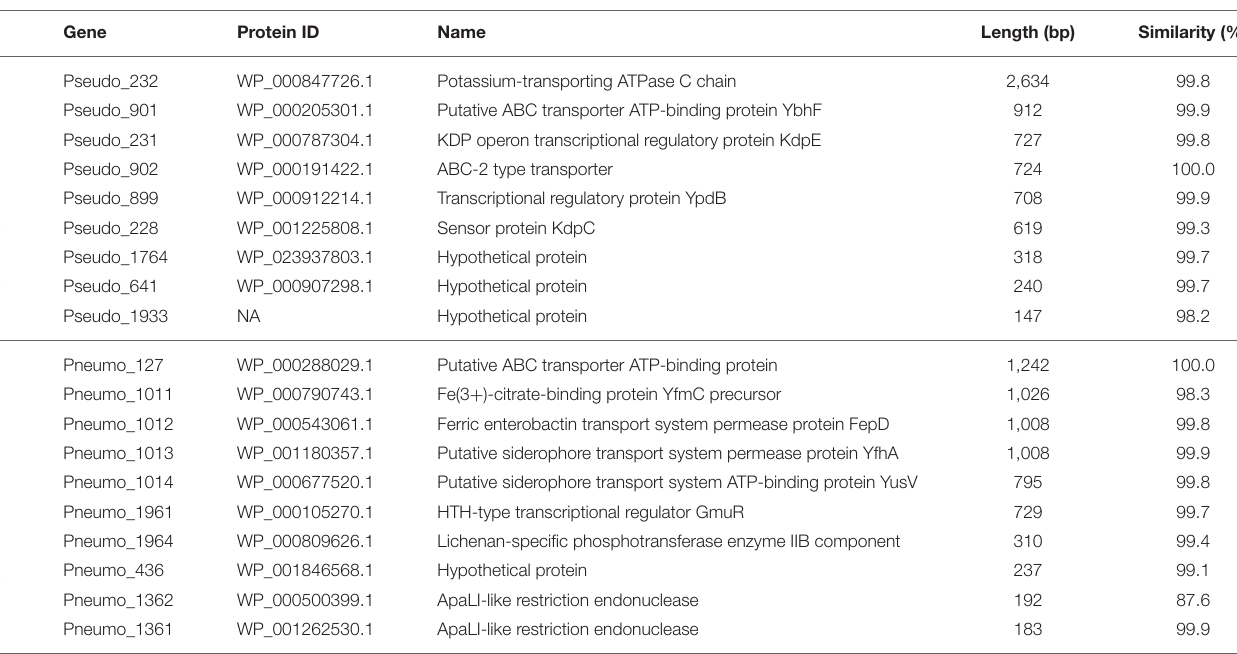
TABLE 3 | List of unique genes of S. pseudopneumoniae and S. pneumoniae